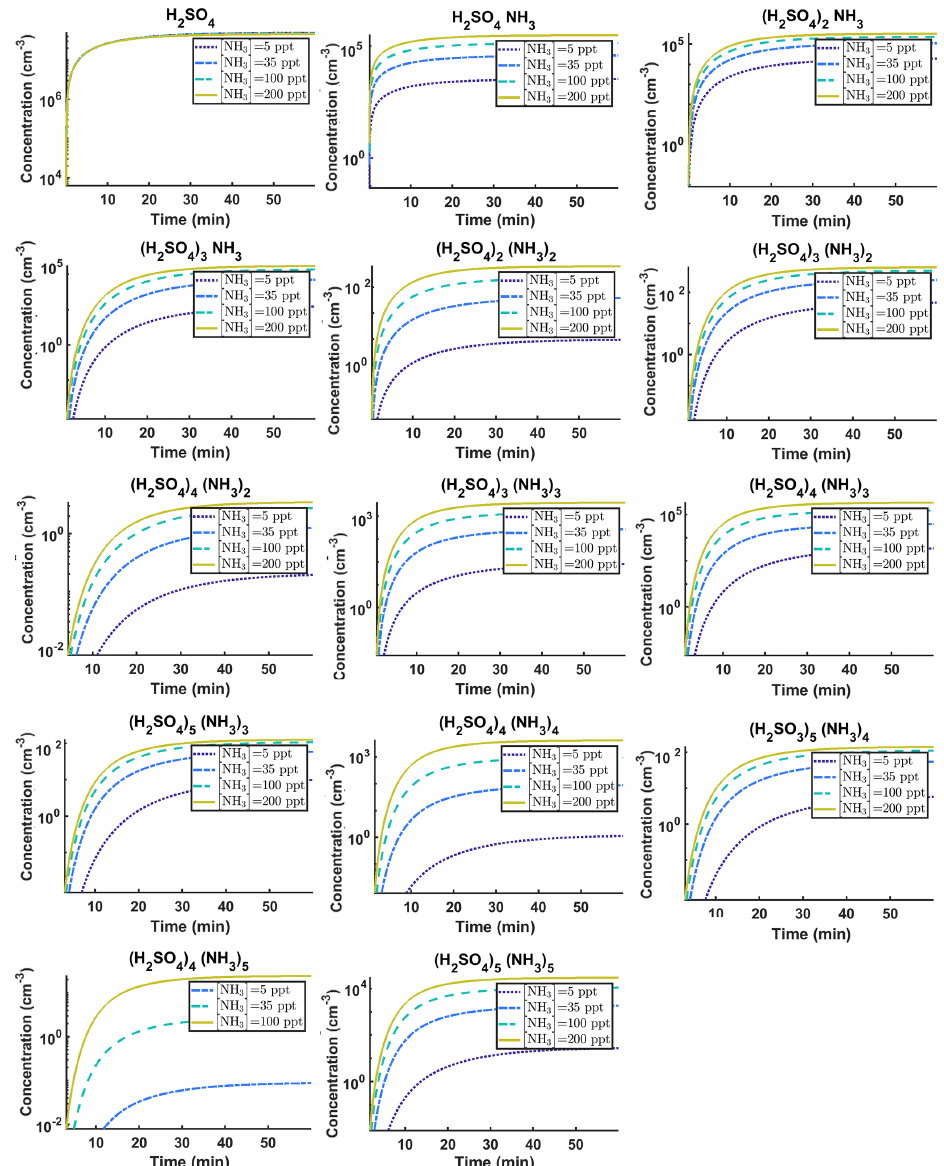
Figure C1. Time-dependent cluster concentrations. Simulated time evolution of concentrations for different cluster types at temperature T = 278K for varying [ NH 3 ] concentration: 5, 35, 100 and 200ppt (see the legend). All the model outputs are amended with multivariate non-correlated Gaussian noise with standard deviation comprising 0.001% of the original cluster concentration. Time resolution comprises 1.5min. The source of sulfuric acid monomer is [ H 2 SO 4 ] = 6 . 3 × 10 4 s − 1 in all simulations. The notation xAyN corresponds to a cluster with x sulfuric acid and y ammonia